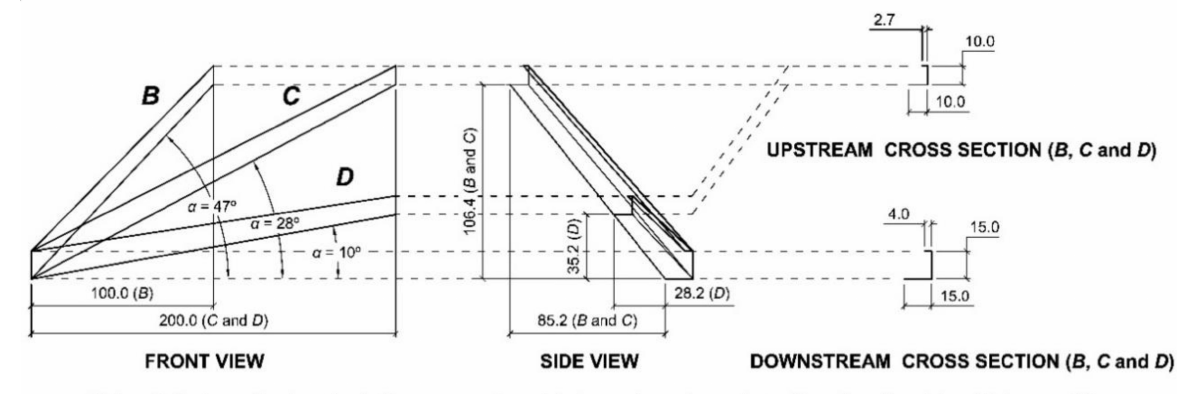
Figure 3. Drawings of the converging chutes for setup configurations B , C , and D . For each HCCs configuration, the chutes were attached to the downstream slope of the gravity dam by steel supports. As mentioned above, the bottom of the HCCs had a constant slope with the horizontal plane. The width of the bottom of the HCCs changed linearly from 10 cm in the upstream cross-section to 15 cm at the downstream end, which was located next to the sidewall of the stilling basin. The sidewall of the converging chute was vertical, 10 cm high in the upstream cross-section and 15 cm at the downstream end (Figure 3). In every cross-section, the top of the vertical sidewall was closed by a 5 cm wide deflector, parallel to the bottom of the converging chute, to both prevent spilling and allow the water to flip, forming a rolling wave as shown in Figure 1b. In addition, the height of the step from the bottom of the basin to the bottom of the downstream section of the